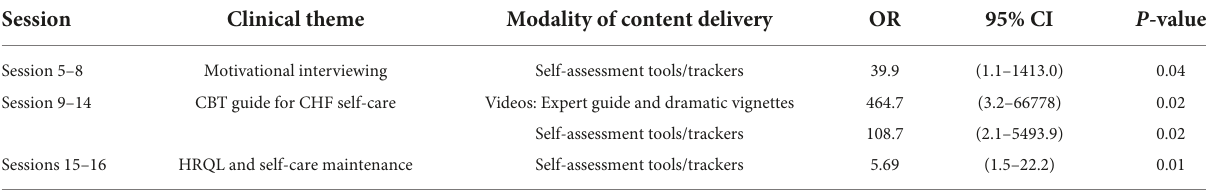
TABLE 4 Association between logon time for clinical content themes in sessions 1–16 and 12-month KCCQ-OS